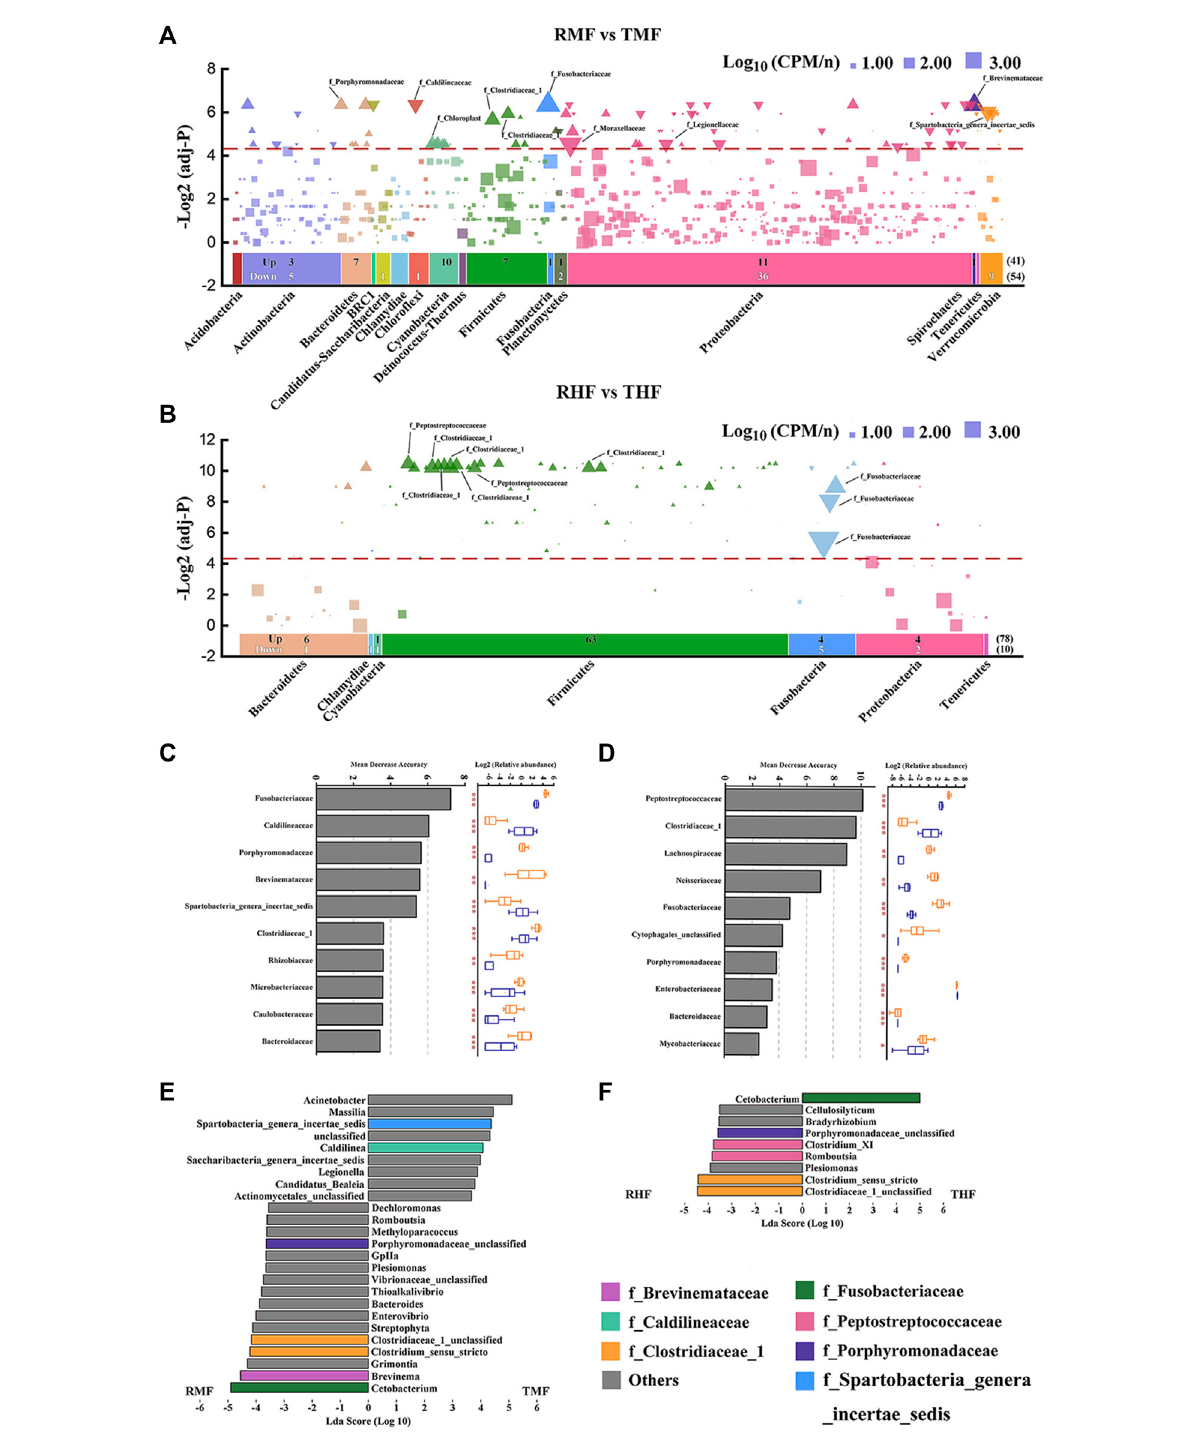
FIGURE 5 Differentially abundant gut bacterial taxa in genetically improved farmed tilapia (GIFT) between culture modes IPRS and PCS. Manhattan plots showing enriched OTUs in (A) midgut and (B) hindgut. No signi fi cant abundanceof OTUs is depicted as a block;OTUs that are signi fi cantly enriched in IPRS are depicted as an upward triangle ( ▲ ); OTUs that are signi fi cantly enriched in PCS are depicted as a downward triangle ( ▼ ). Dashed lines correspond to the false discovery rate-corrected p -value threshold of signi fi cance ( α = 0.05). The color of each dot represents the different taxonomic af fi liation of the OTUs (phylum level), and the size corresponds to their relative abundance in the respective samples. Up: the amount of